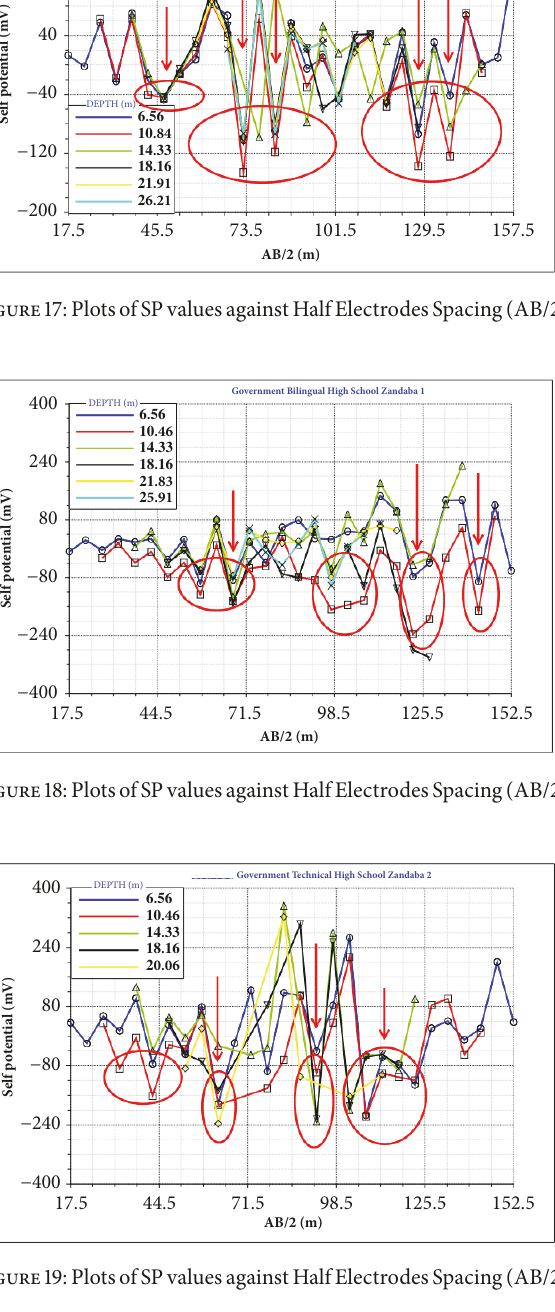
Figure16:PlotsofSPvaluesagainstHalfElectrodesSpacing(AB/2).